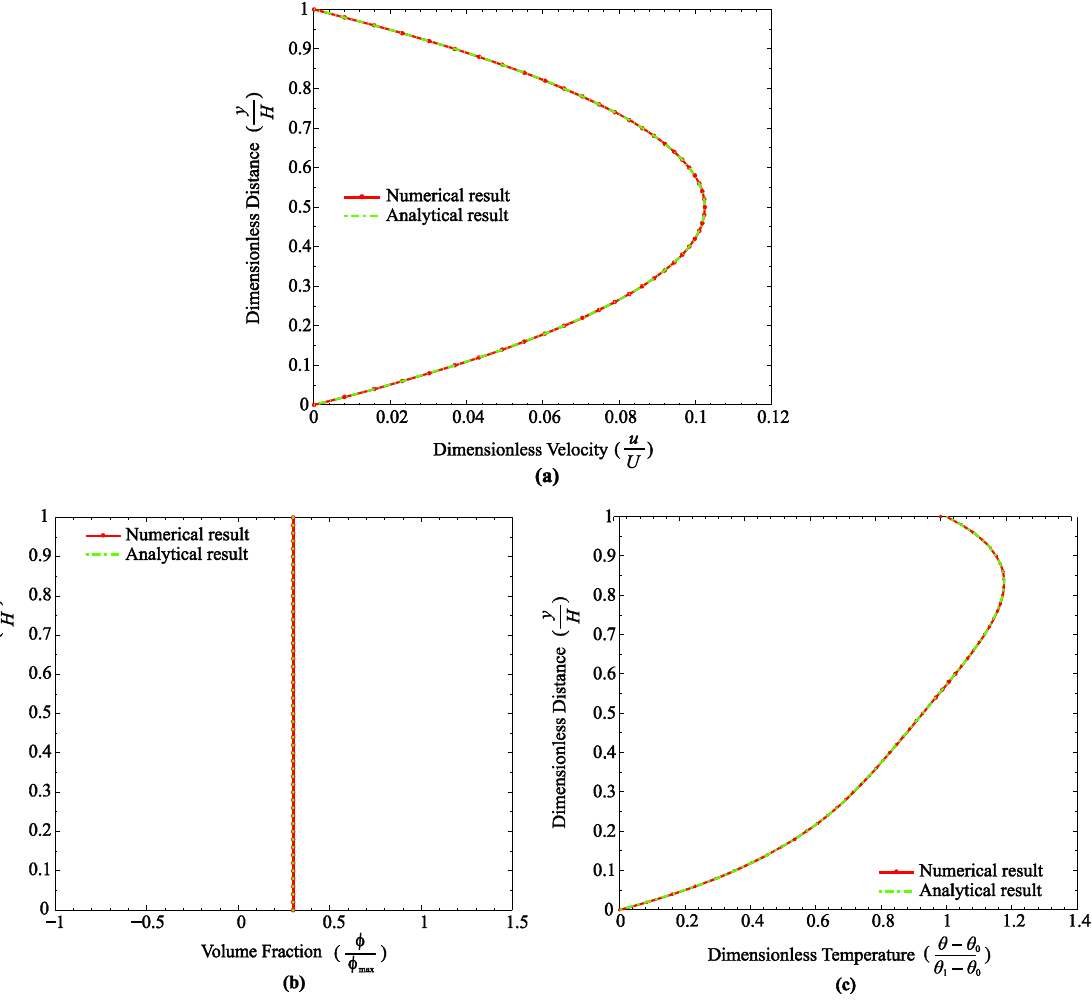
Figure 3. ( a ) velocity profiles ( b ) volume fraction profiles ( c ) temperature profiles from the analytical and numerical solutions. 𝑚 = 0, 𝑀 = 0, 𝐵 𝑇 = 1.5, 𝑁 = 0.3, 𝑅